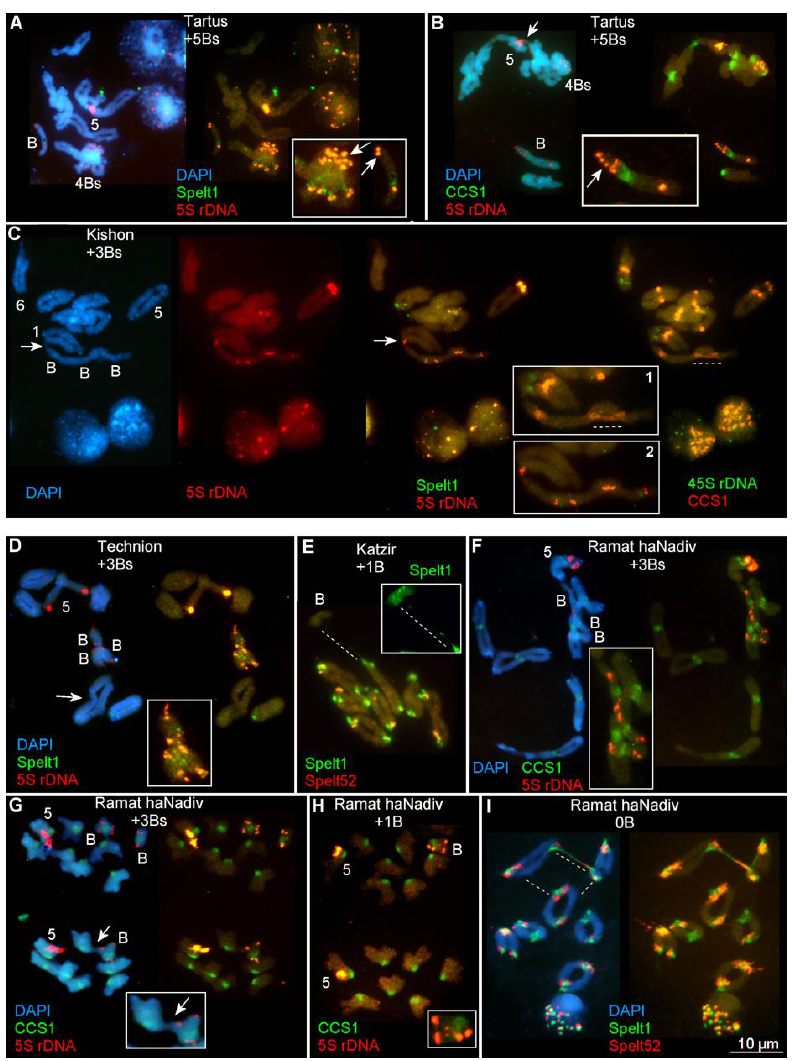
Figure 3. Ectopic chromosome associations and B chromosome rearrangements during microsporogenesis in different genotypes of Aegilops speltoides . Meiotic chromosomes at the diakinesis ( A ) and diplotene ( B ) stages of the plant from Tartus (2 n = 2x = 14 + 5B). ( A ) Four B chromosomes form a tetravalent; in their short arms, the number of 5S rDNA clusters is doubled. The fifth B chromosome acts as a univalent; there is a single 5S rDNA cluster in its short arm (arrows, enlargement in the small box). ( B ) In the diplotene stage, four Bs form a tetravalent. In the univalent B, translocation of the 5S rDNA cluster occurs in the short arm (arrow, enlargement in the small box). Nonhomologous association of A chromosomes is indicated with arrow. ( C ) Meiotic chromosomes at the diakinesis stages of the plant from Kishon (2 n = 2x = 14 + 3B). FISH with 5S rDNA (in red) and Spelt1 (in green); re-probing with 45S rDNA (in green) and CCS1 (in red). The three Bs synapse at their terminal regions and form a chain, which is associated ectopically with chromosome 1 (arrow) (enlargement in the small box 2). The pericentromeric regions of two Bs recombine (dashed line, small box 1). ( D ) Meiotic chromosomes at the diakinesis stage of the plant from Technion (2 n = 2x = 14 + 3B). Three Bs form a trivalent (enlargement in the small box). Tetravalent of A chromosomes is shown with arrow . ( E ) Meiotic chromosomes at the diakinesis stage of the plant from Katzir (2 n = 2x = 14 + B). Stretched Spelt1 fiber between the B and A chromosomes indicate ectopic recombination (dashed line, enlargement in the small box). ( F ) Meiotic chromosomes at the diakinesis stage of the plant from Ramat haNadiv (2 n = 2x = 14 + 3B). Ectopic associations between three Bs and two bivalents of standard chromosomes are revealed (enlargement in the small box). ( G ) Meiotic chromosomes at the anaphase I stage of the plant from Ramat haNadiv (2 n = 2x = 14 + 3B). Ectopic association between A and B chromosomes moving toward the same pool is stressed (arrow, enlargement in the small box). ( H ) Meiotic chromosomes at the anaphase I stage of the plant from Ramat haNadiv (2 n = 2x = 14 + B). An additional 5S rDNA cluster is revealed in the long arm of the B chromosome (enlargement in the small box). ( I ) Meiotic chromosomes at the diakinesis stage of the plant from Ramat haNadiv (2 n = 2x = 14). Ectopic associations between nonhomologous chromosomes are shown with dashed lines. In the genotype Tartus (3B), among 30 cells analyzed on the same cytological slide, in 20 cases, B-A ectopic associations were detected. In the genotype Kishon (3B), among 28 cells analyzed, in 18 cells, B-A associations were revealed. In the genotype Technion (3B), among 32 cells analyzed on two slides, in 23 cells, B-A associations were revealed. In the genotype Ramat haNadiv (1B), among 15 cells analyzed on the same slide, in 9 cases, B-A associations were detected. In the genotype Ramat